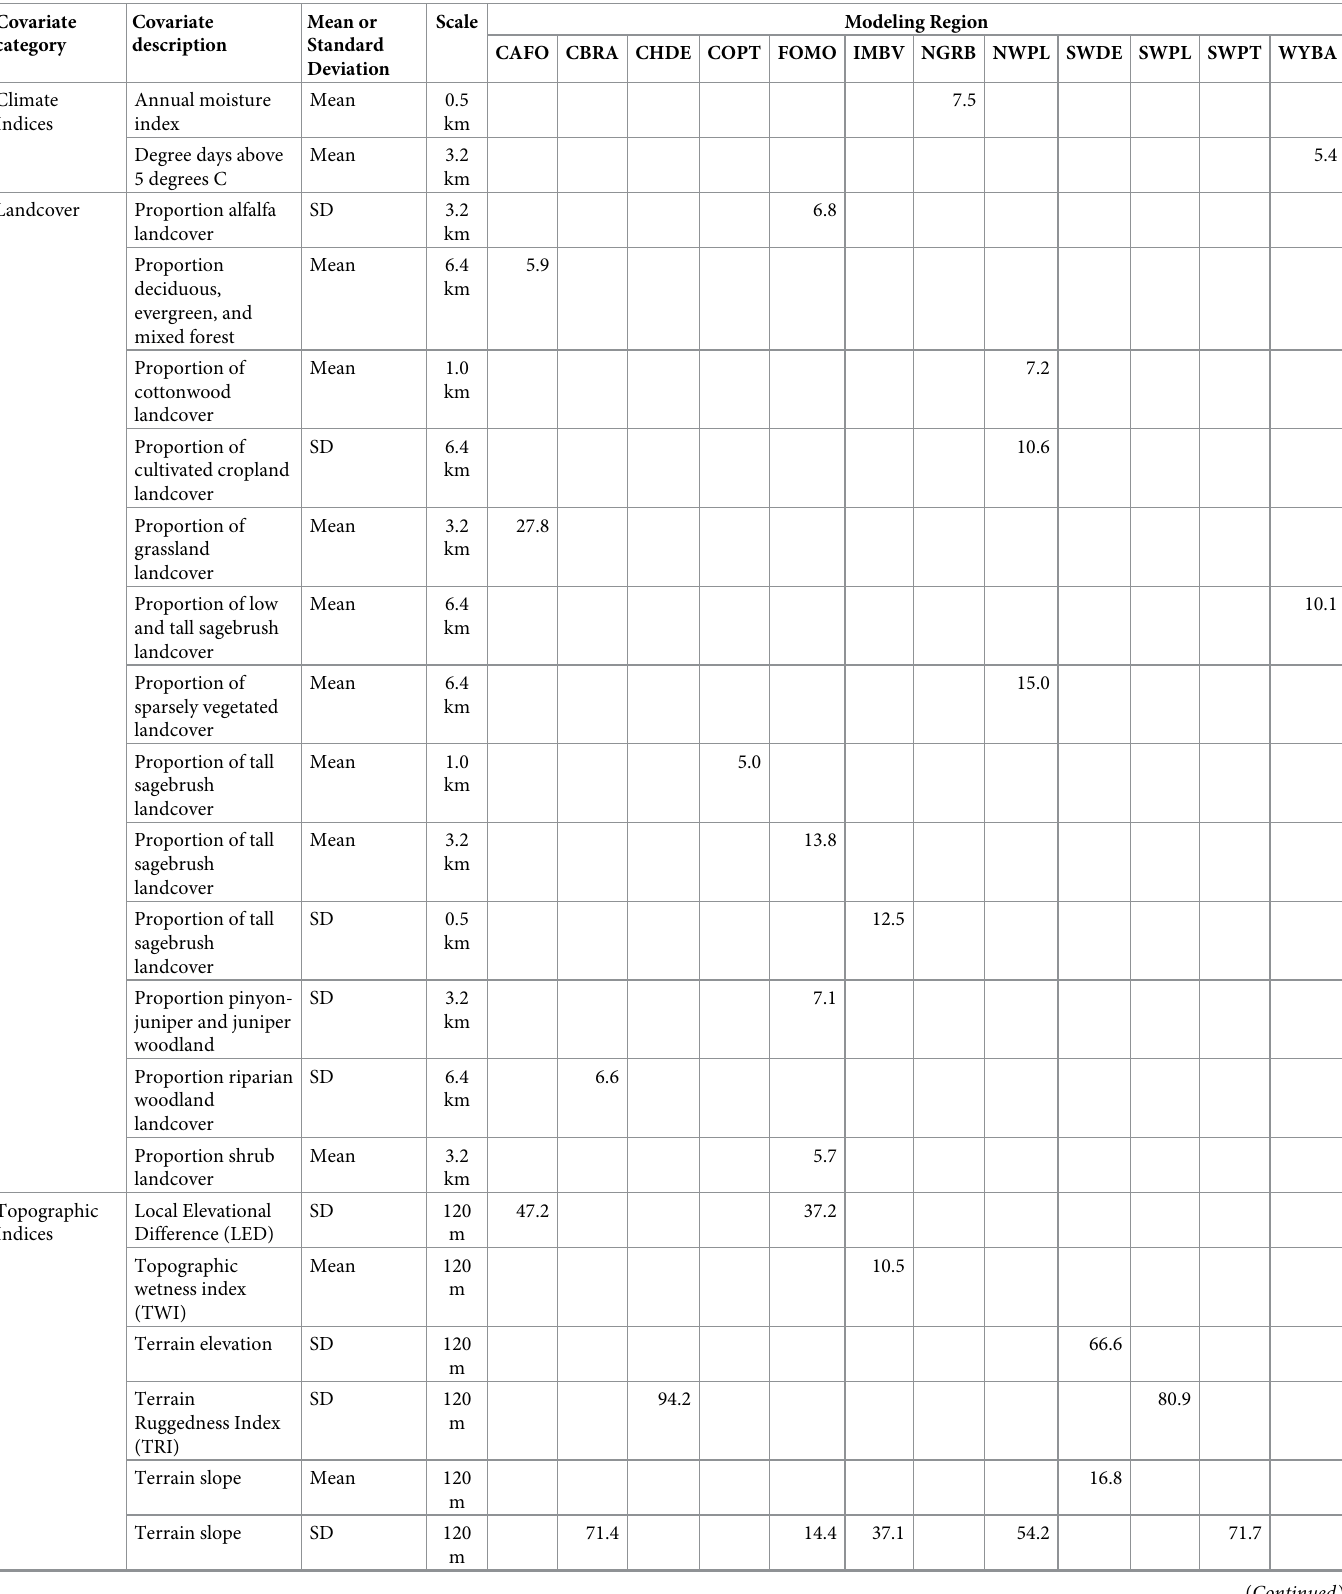
Table 3. List of covariates that contributed � 5% to each modeling region’s final model. Values beneath each modeling region are the covariate’s percentage contribu- tion to fitting each final model. Covariate